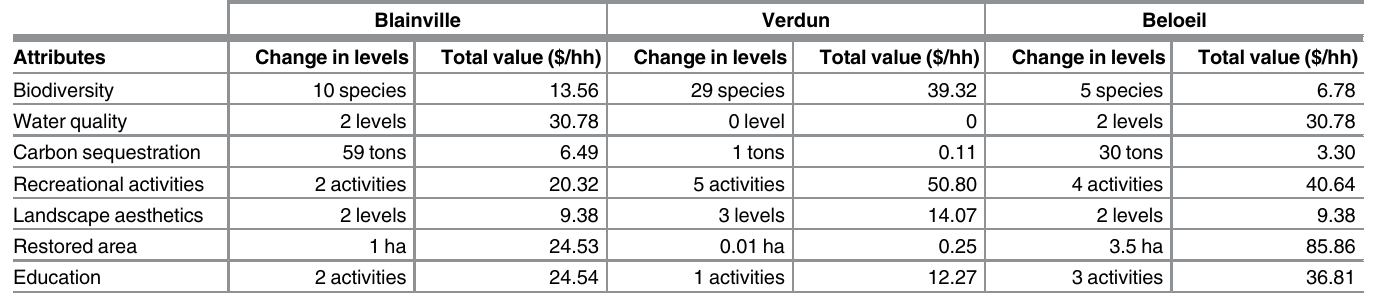
Table 5. Total non-market economic value per household for each restoration